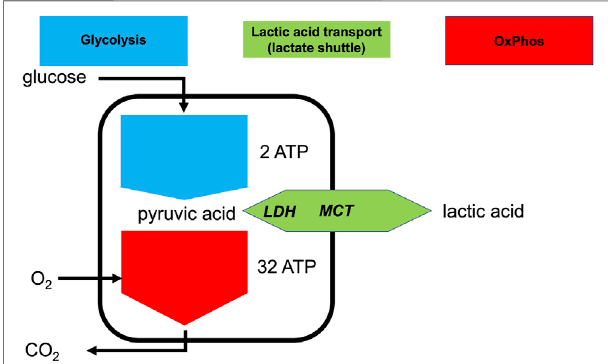
FIGURE 1 | Lactate shuttling allows the uncoupling of glycolysis and OxPhos at the cellular level. Simpli fi ed depiction of aerobic and anaerobic metabolism of glucose consumption and production or consumption of lactic acid. Intracellular lactate dehydrogenase (LDH) can interconvert pyruvate and lactate and the monocarboxylate transporter (MCT) can export or import lactic